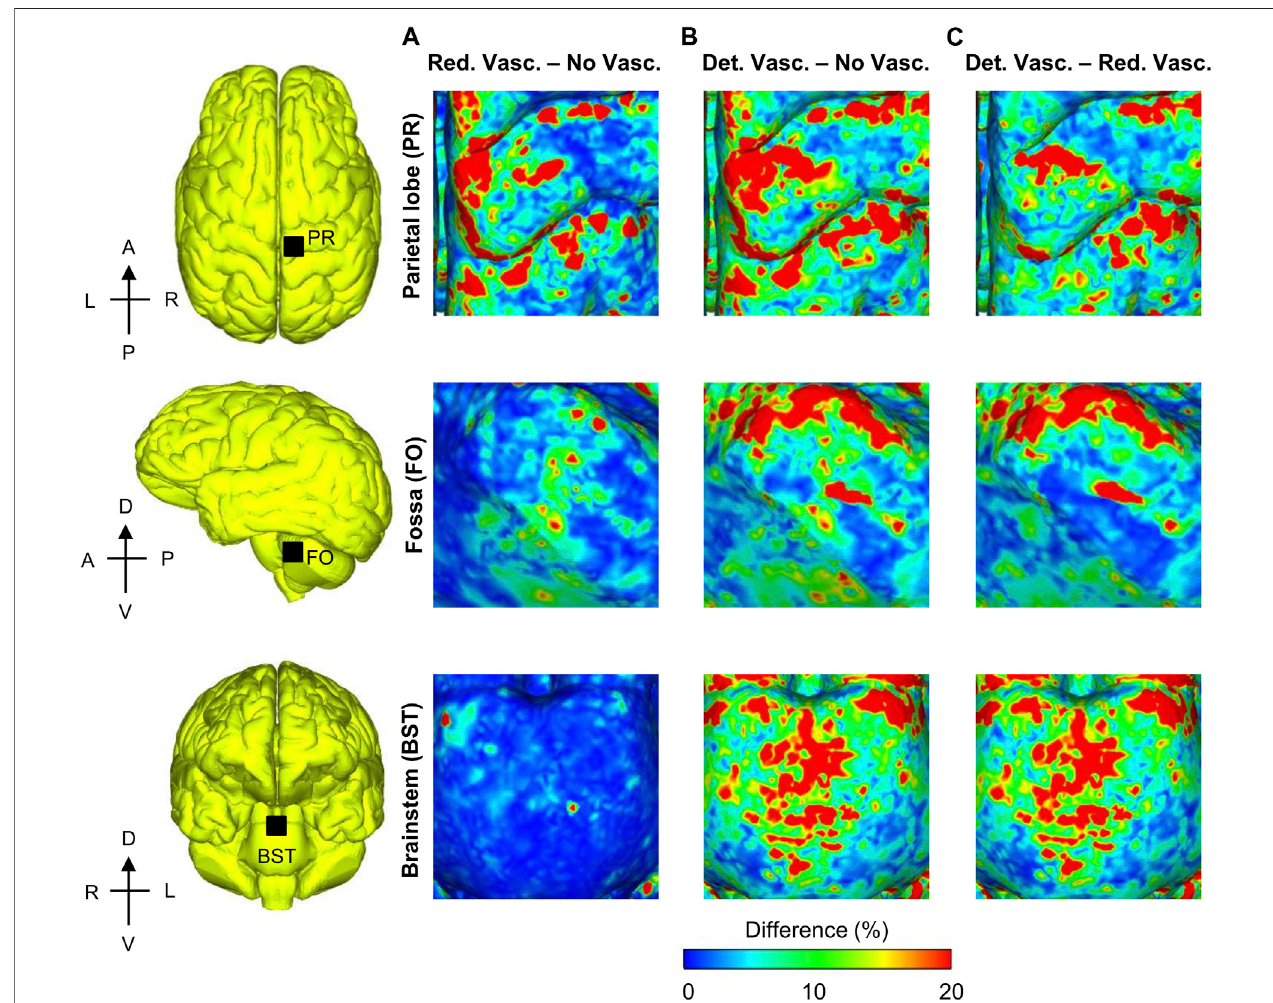
FIGURE9| Differencesinthepeakstraingradientbetweenmodelsforthe104 kPablastoverpressureforthreeregionsinthebrain.Shownarethedifferencemaps comparing the peak strain gradient between the reduced- and no-vasculature models (A) , between the detailed- and no-vasculature models (B) , and between the detailed-andreduced-vasculaturemodels (C) .Foreachpairofcomparisons,wecomputeddifferencesinmodelpredictionsby fi rstdeterminingthepeakstraingradient foreachmodelateachtetrahedralelementofthehumanbrainovertheblast-exposuresimulationtime,andthensubtractingthem.Det.Vasc.:detailed-vasculature model; Red. Vasc.: reduced-vasculature model; No Vasc.: no-vasculature model; A: anterior; P: posterior; R: right; L: left; D: dorsal; V: